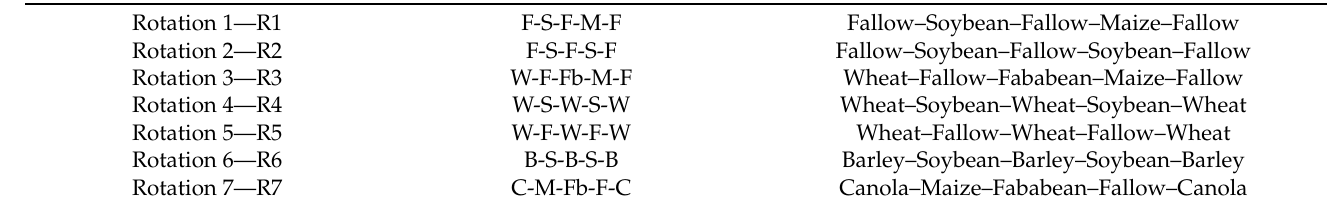
Table 2. Winter–summer crop sequence scenarios used in the